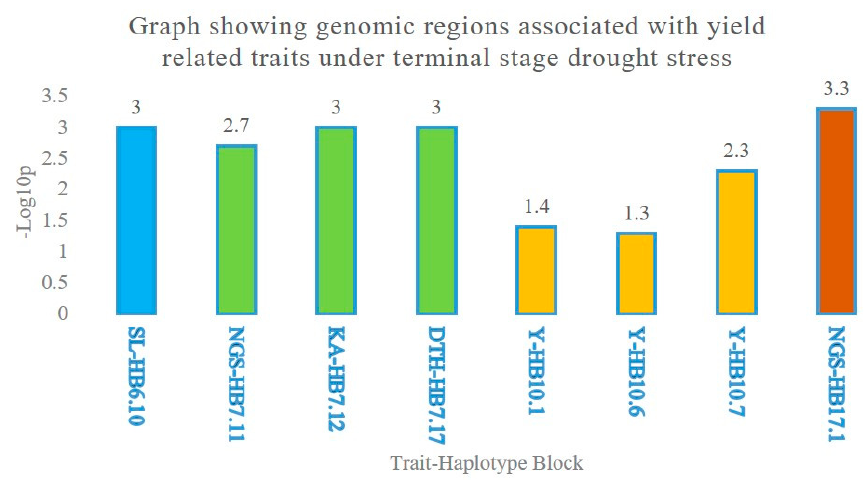
Figure 7. Graph showing genomic associations for grain yield and related traits under terminal stage drought stress in wheat. On x -axis traits and haplotype blocks were denoted and –Log10p value was plotted on the y -axis. Y = Grain yield, KA = Kernel abortion, SL = Spike length and NGS = Number of grains per spike.